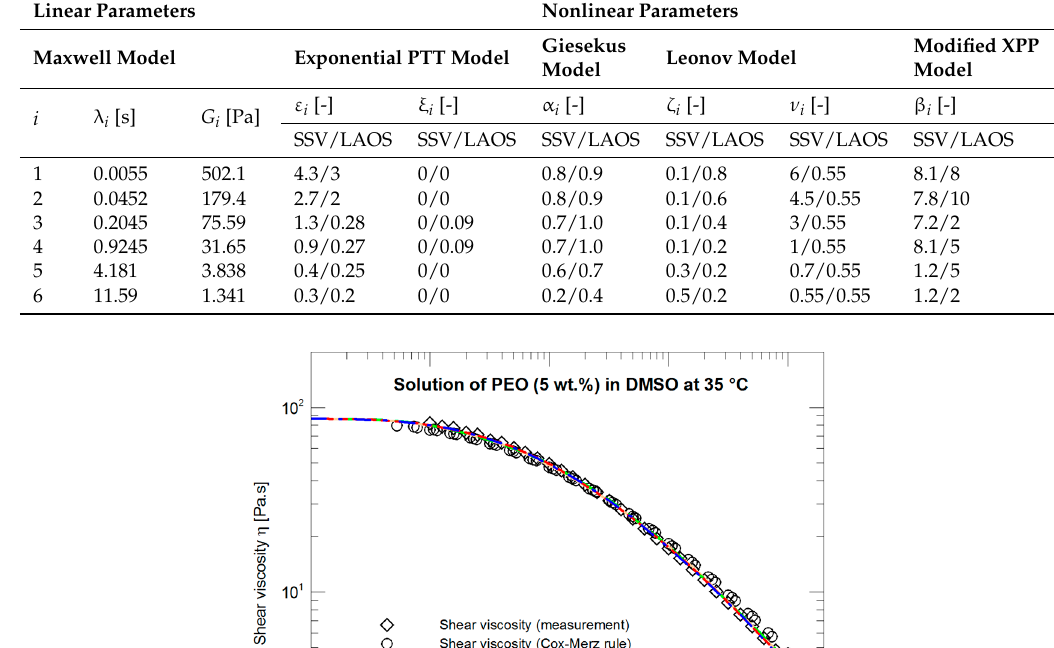
Table 2. Relaxation spectrum and the nonlinear parameters of the constitutive models based on optimization of steady shear viscosity (SSV) and on fitting LAOS data (LAOS).